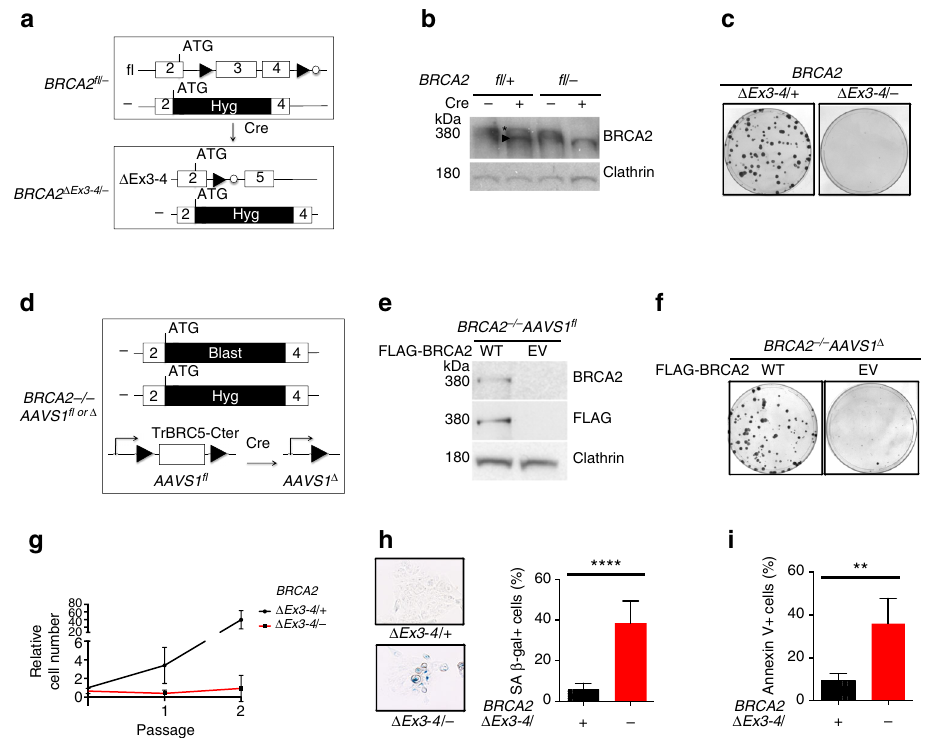
Fig. 1 BRCA2 is essential for non-transformed human mammary MCF10A cell viability. a Schematic of the BRCA2 exon3-4- fl oxed conditional system in MCF10A cells ( fi lled triangle , loxP site; open circle , FRT site; Hyg, hygromycin-resistance gene). b Western blot of BRCA2 exon3-4- fl oxed cell extracts with or without Cre expression ( asterisk , full-length BRCA2; arrowhead , Δ Ex3-4 peptide). The BRCA2 antibody Ab-1 detects BRCA2 amino acids 1651 – 1821. c BRCA2 Δ Ex3-4/ − cells were plated for clonogenic survival. Representative plates are shown. d Schematic of the BRCA2 − / − AAVS1 fl conditional system in MCF10A cells. Blast, Blasticidin-resistance gene. e Western blot showing BRCA2 expression in stably complemented BRCA2 − / − AAVS1 fl cells ( WT , wild- type BRCA2; EV , empty vector). f BRCA2 − / − AAVS1 Δ cells were plated for clonogenic survival. g BRCA2 Δ Ex3-4/ − cells were serially passaged every 3 days. Cell number was determined at the end of each passage and normalized to the number of BRCA2 Δ Ex3-4/ + cells at passage 0. h Cells were stained for senescence-associated β -galactosidase (SA β -gal). Left : representative images; Right : comparison of the percent SA β -gal+ cells. i Cells were quanti fi ed for apoptosis using Annexin V staining. Error bars in this fi gure represent one standard deviation from the mean (s.d.). n > 3. ** p < 0.01; **** p <